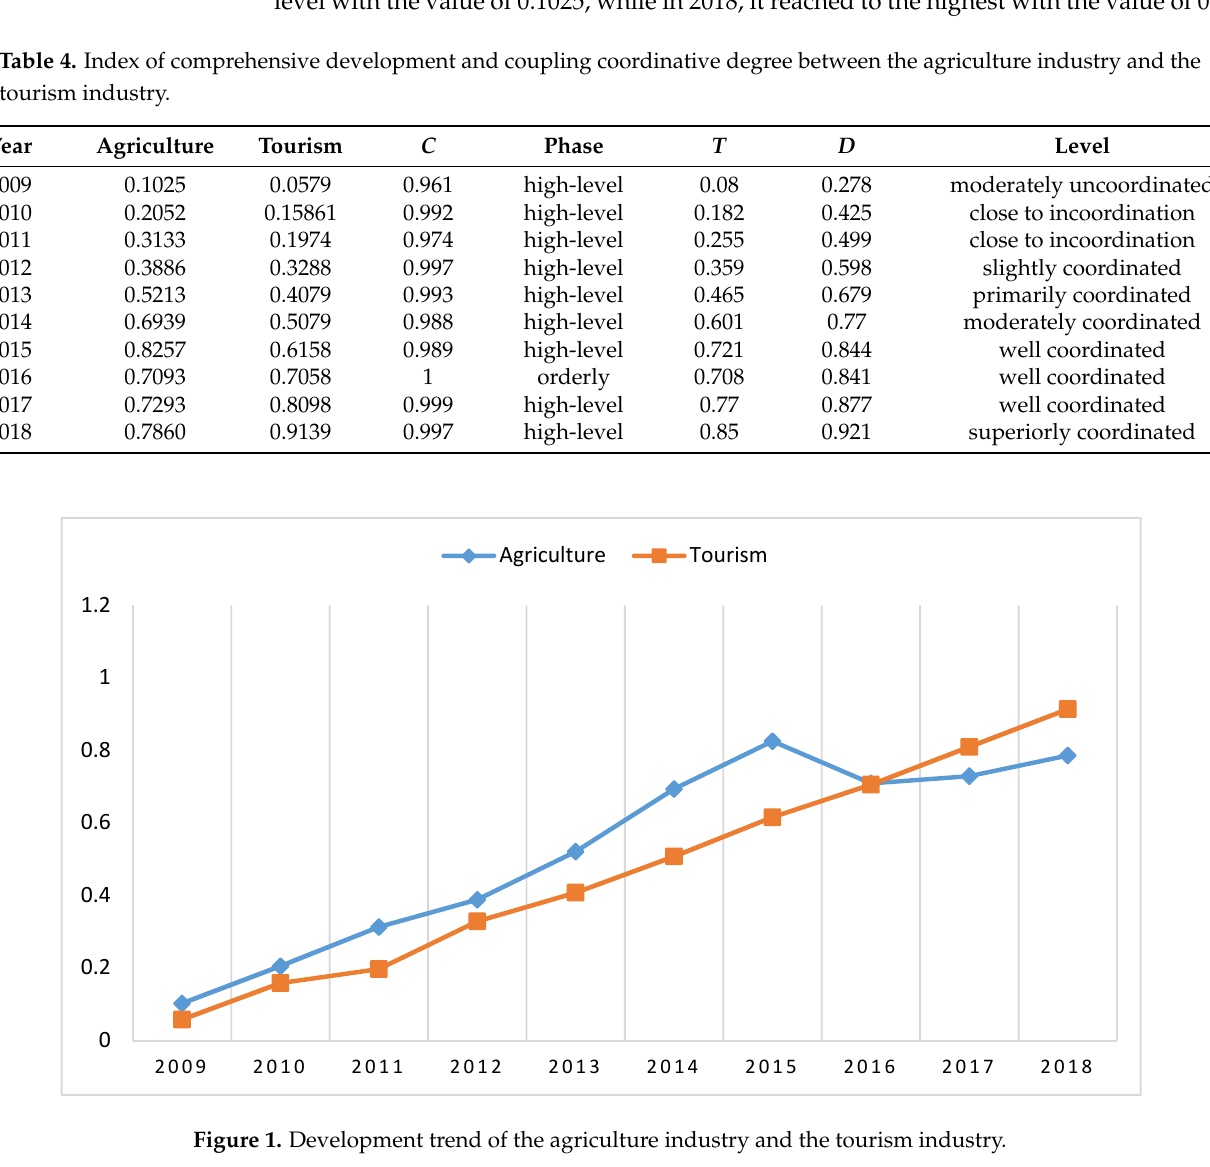
Figure 2. Trend of coupling coordinative degree between the agriculture industry and the tourism industry.